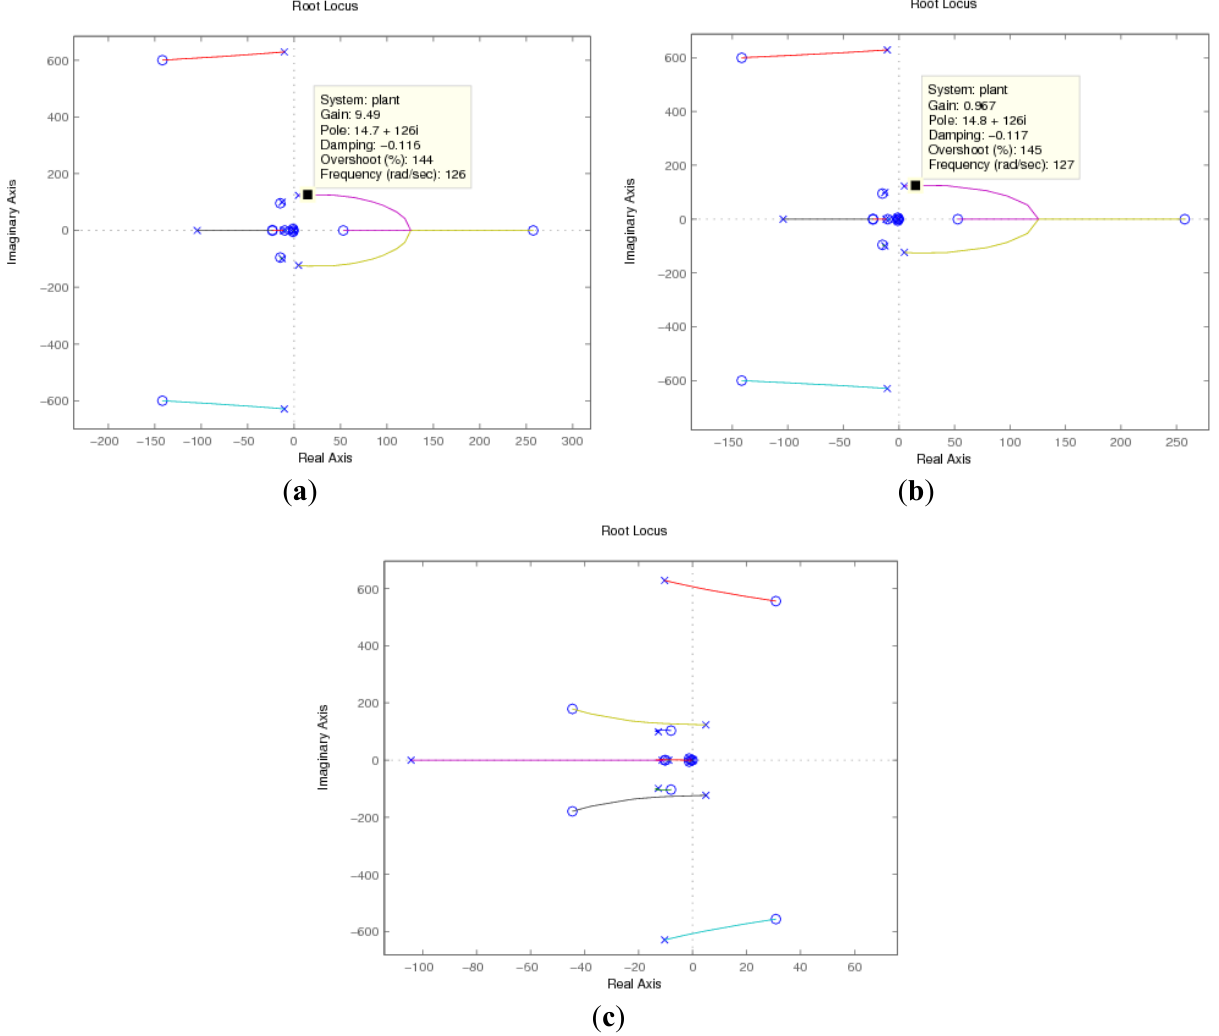
Figure 6. The root locus diagrams of the open-loop system with the line current as the feedback signal and different modulated-voltage injections (a) to the d-axis of the GSC outer loop, ( b ) to the d-axis of the GSC inner loop, and ( c ) to the q-axis of the GSC inner